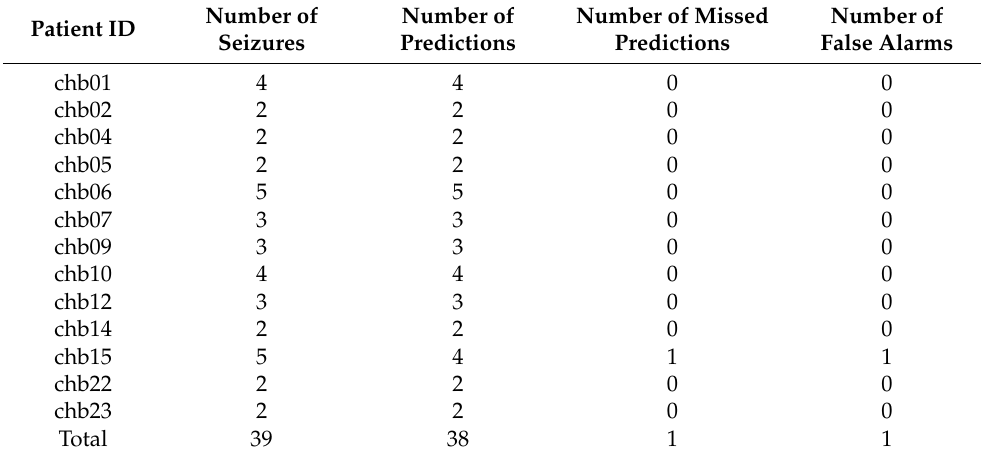
Table 5. Prediction results (InT = 30 min).